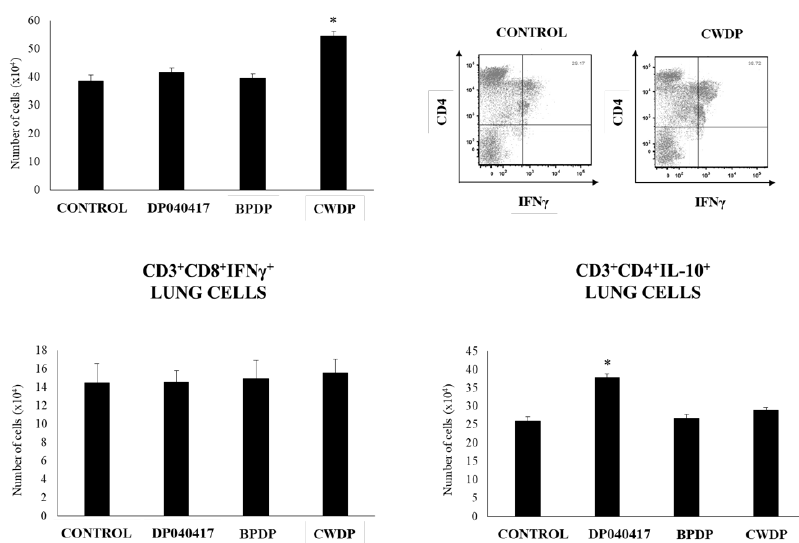
Figure 6. Effect of Dolosigranulum pigrum 040417 on respiratory immune cell populations. Viable (DP), bacterium-like particles (BPDP) or cell wall (CWDP) from D. pigrum 040417 were nasally administered to infant mice during five consecutive days. Non-treated infant mice were used as controls. The numbers of CD3 + CD4 + IFN- γ + , CD3 + CD4 + IL-10 + , and CD3 + CD8 + IFN- γ + T lymphocytes in lungs were determined by flow cytometry one day after the last treatment. Experiments were performed with 5–6 mice per group. The results represent data from three independent experiments. Significantly different when compared to control * p < 0.05 or ** p < 0.01.